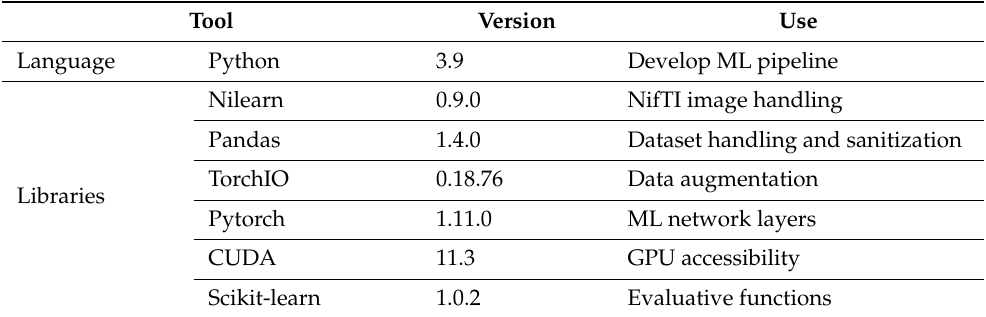
Table 2. Development